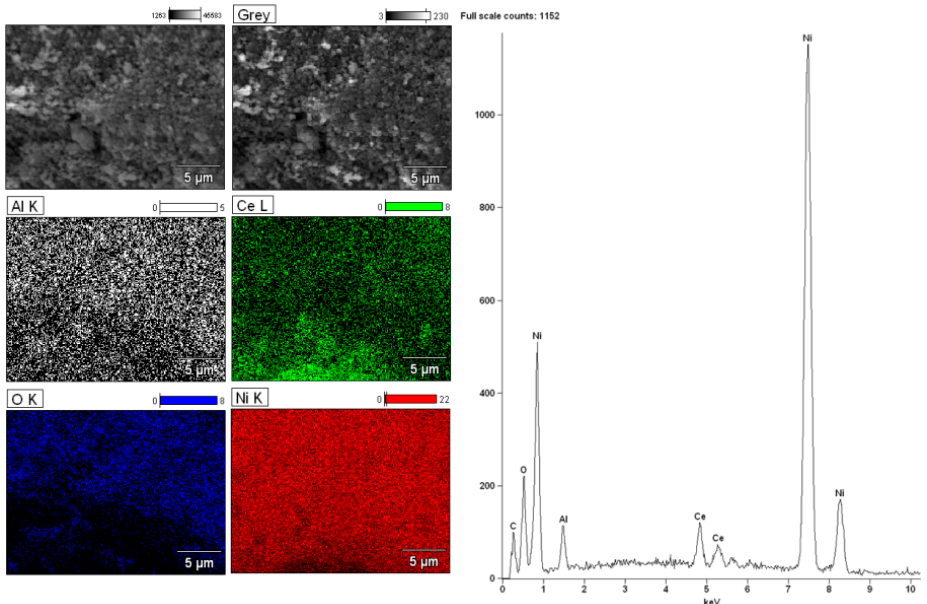
Figure 10. SEM images and EDS spectra for the bimetallic 2%Pd–40%Ni/CeO 2 –Al 2 O 3 catalysts calcined at 400 °C in air atmosphere for 4 h.